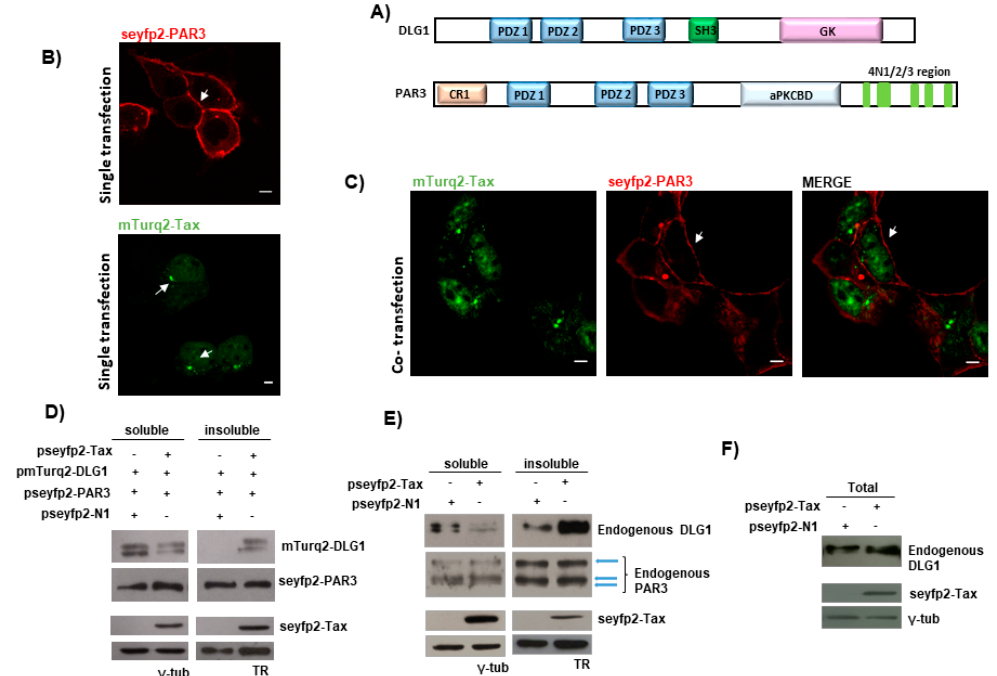
Figure 2. The DLG1-Tax co-localization pattern does not arise from an overabundance of PDZ domains inside the cell. ( A ) Schematic representation of DLG1 and PAR3 proteins, showing that both proteins bear three PDZ domains. SH3, interaction domain Src homology 3; GK, homologous to the yeast guanylate kinase enzyme; CR1, oligomerization domain; aPKCBD, atypical protein kinase C binding domain; ( B ) Subcellular distribution of the PAR3 PDZ-containing protein and Tax in epithelial cells. A plasmid encoding seyfp2 tagged PAR3 or mTurq2 tagged Tax was transfected in HEK293 cells and its expression was analyzed by confocal microscopy (red); ( C ) Simultaneous overexpression of Tax and PAR3 proteins in epithelial cells. The plasmids encoding seyfp2-PAR3 (red) and mTurq2-Tax proteins (green) were co-transfected in HEK293 cells and co-localization between both proteins was tested. In ( B , C ), the white arrows indicate the expression of the over-expressed proteins as described in the text. All scale bars are 5 µm; ( D ) Influence of Tax expression over ectopic DLG1 and PAR3 subcellular distribution. HEK293 cells transfected with pseyfp2-Tax or with the control empty vector pseyfp2-N1 together with the pmTurq2-DLG1 or pseyfp2-PAR3 expressing plasmids were harvested, and detergent soluble and insoluble fractions were separated by centrifugation. The mTurq2-DLG1, seyfp2-PAR3, and seyfp2-Tax expression levels in each fraction were assessed by Western blot using anti-green fluorescent protein (anti-gfp) antibody; ( E ) Influence of Tax expression over endogenous DLG1 and PAR3 subcellular distribution. HEK293 cells transfected with pseyfp2-Tax or with the control empty vector pseyfp2-N1 were harvested, and detergent soluble and insoluble fractions were separated by centrifugation. Endogenous DLG1 and PAR3 expression levels in each fraction were assessed by Western blot using anti-DLG1 and anti-PAR3 antibodies. The seyfp2-Tax expression was ascertained using an anti-gfp antibody. For ( C , D ), the γ -tubulin and Transferrin receptor (TR) expression, which were detected with anti- γ -tubulin and anti-TR antibodies, were used as loading control; ( F ) Influence of Tax expression over DLG1 total levels. HEK293 cells transfected with pseyfp2-Tax or with the control empty vector pseyfp2-N1 were harvested, and total protein extracts were separated by SDS-PAGE. The endogenous DLG1 expression level was assessed by Western blot using anti-DLG1, and seyfp2-Tax expression was ascertained using an anti-gfp antibody.